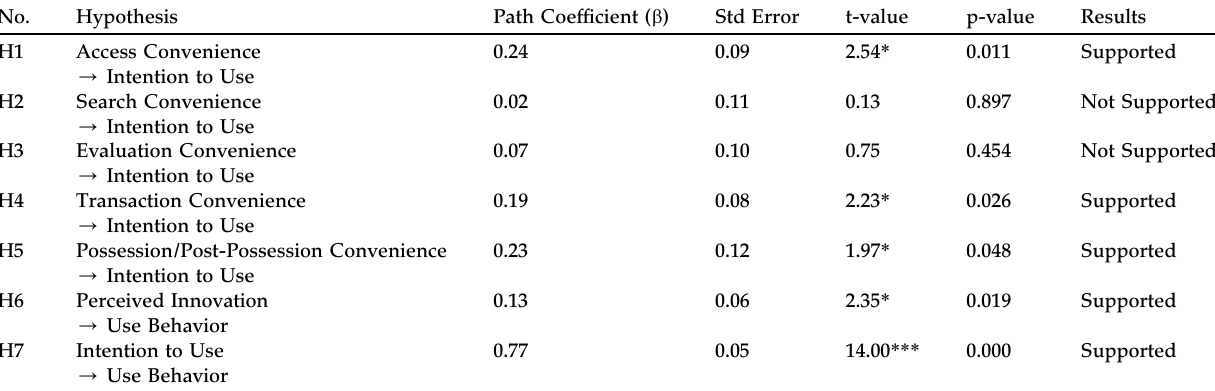
Table 4. The summary of direct hypothesis